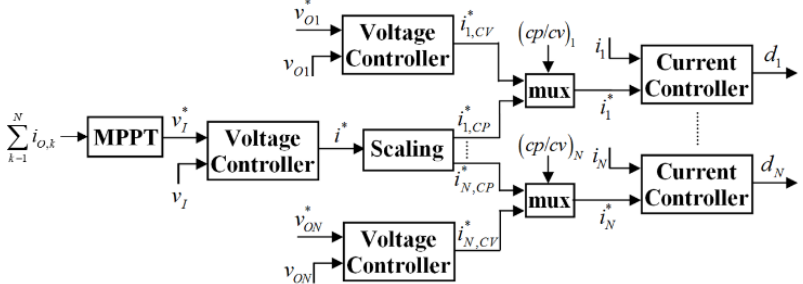
Figure 14. Multi-battery dual-mode control